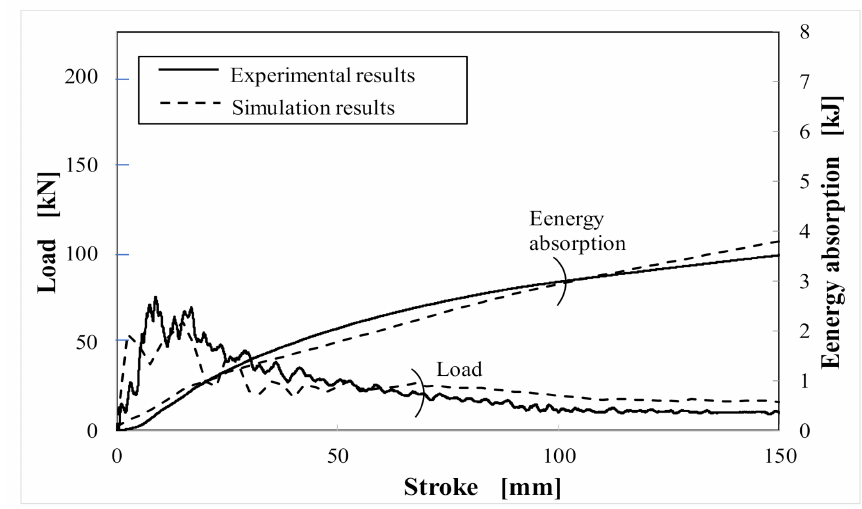
Figure 14. Relationship between load and stroke of overall-quenched product in axial crash test.